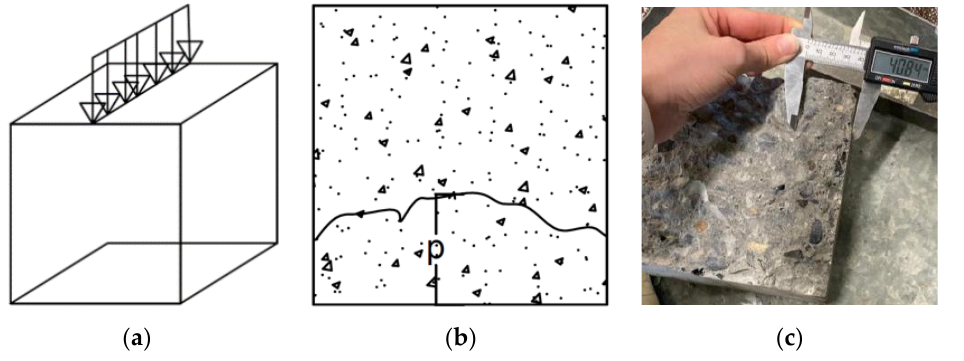
Figure 7. ( a ) Load distribution model used to split the cubes, ( b ) Highest line of water penetration ( c ) water penetration measurement.